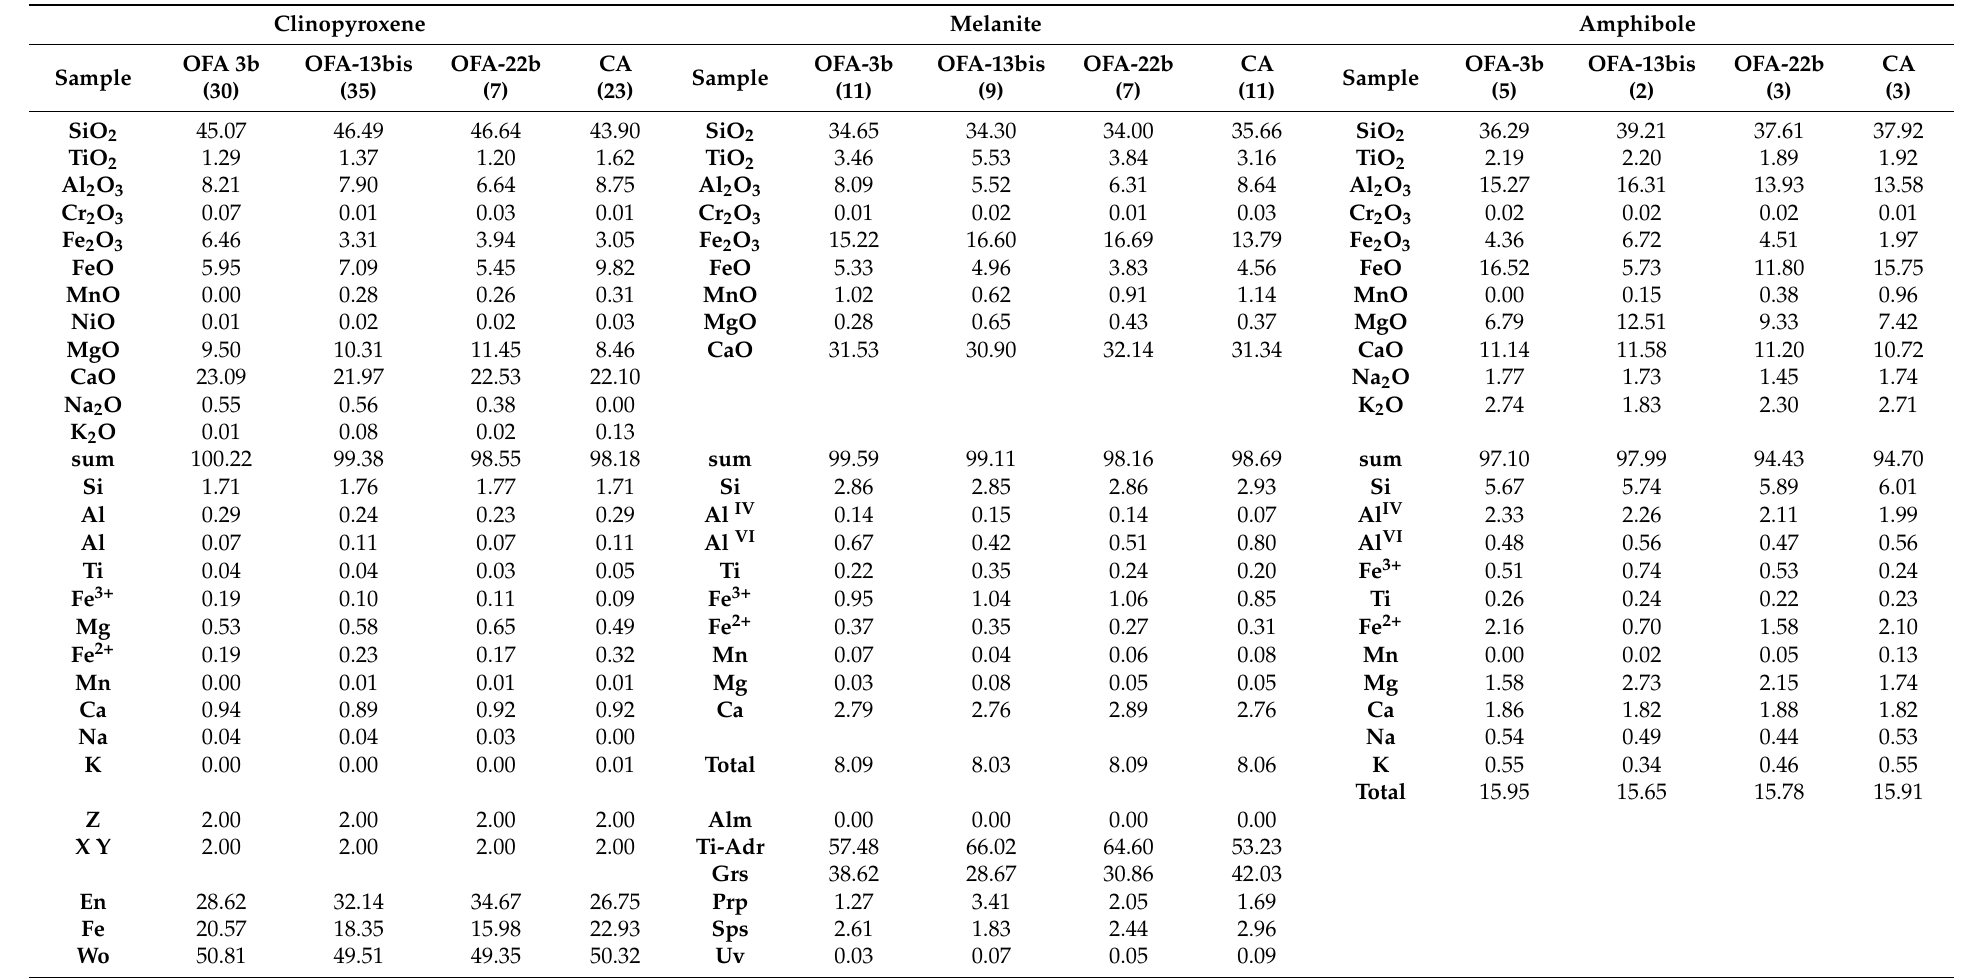
Table 3. Average composition of the volcanic heavy minerals obtained by